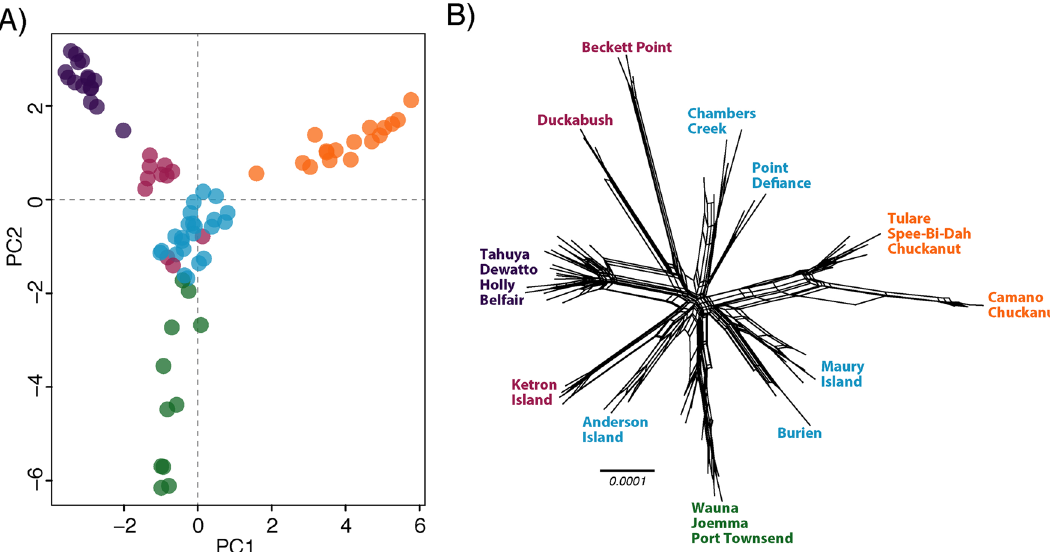
Figure 2. Genetic diversity of Sceloporus occidentalis in Western Washington. ( A ) Principal components analysis (PCA) of genetic variation using 3491 loci in the R package ‘adegenet’. ( B ) Network analysis using the same dataset as the PCA demonstrates that samples from the same locality form distinct genetic clusters. Colors correspond to the population assignments from ADMIXTURE assuming K -value =